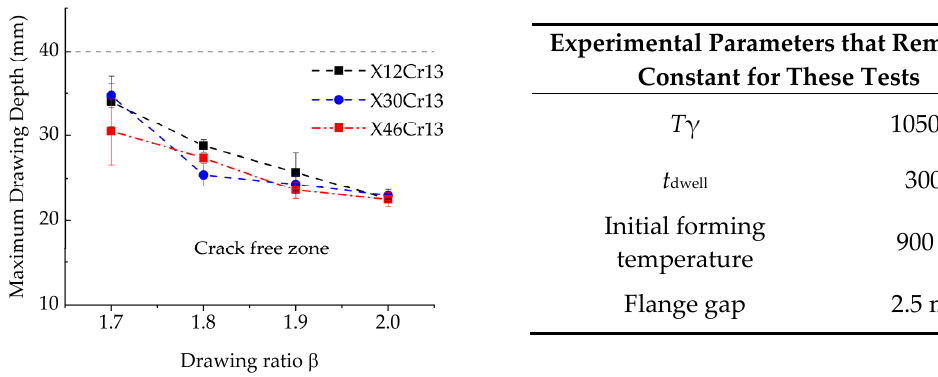
Figure 9. Maximum drawing depth as a function of the drawing ratio.